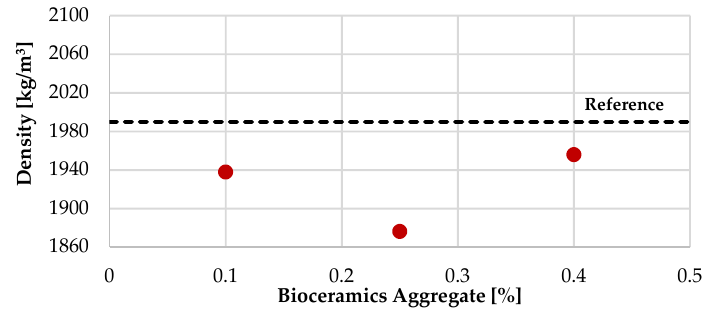
Figure 8. Dry state density results for cement mortars.